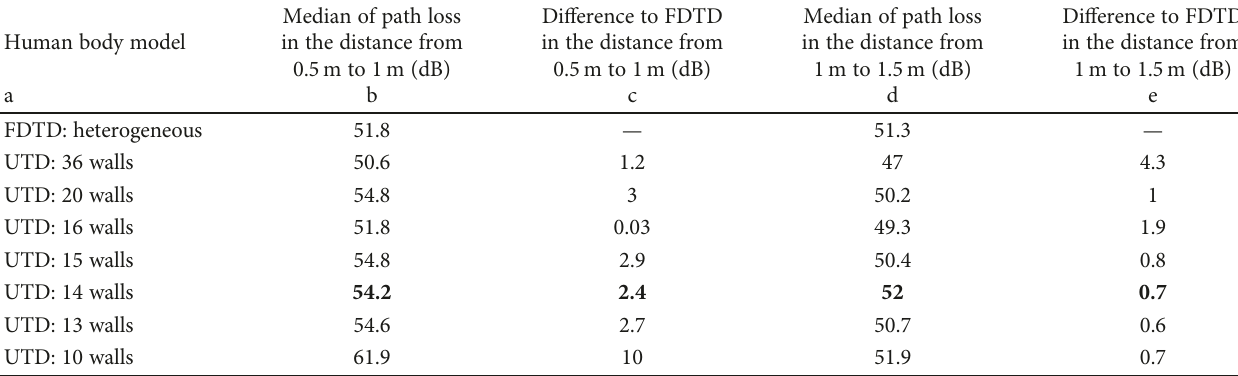
Table 1: Median values of path loss obtained for di ff erent geometries of models — body orientation 1. Human body model